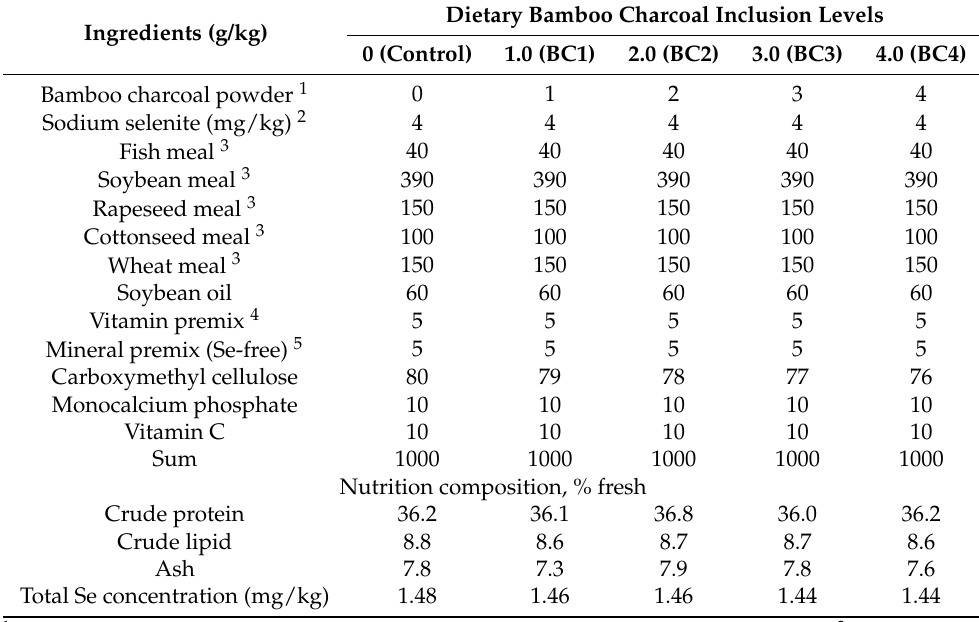
Table 1. Ingredients and nutrient composition of experimental